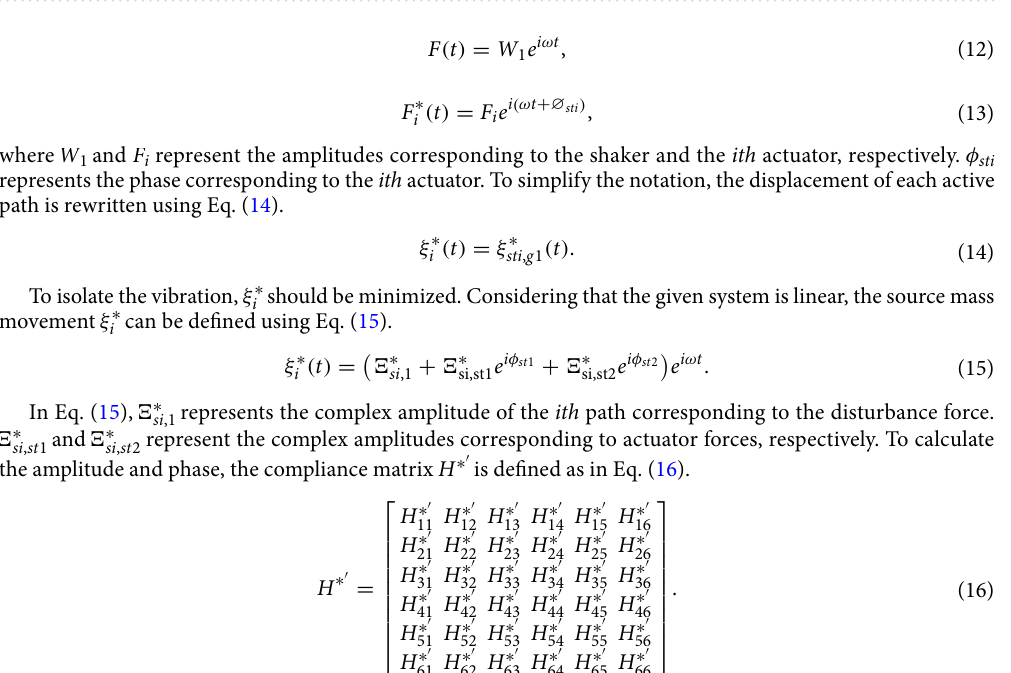
Figure 6. Schematic representation: ( a ) Coordinates at center of mass and ( b ) Coordinates at active